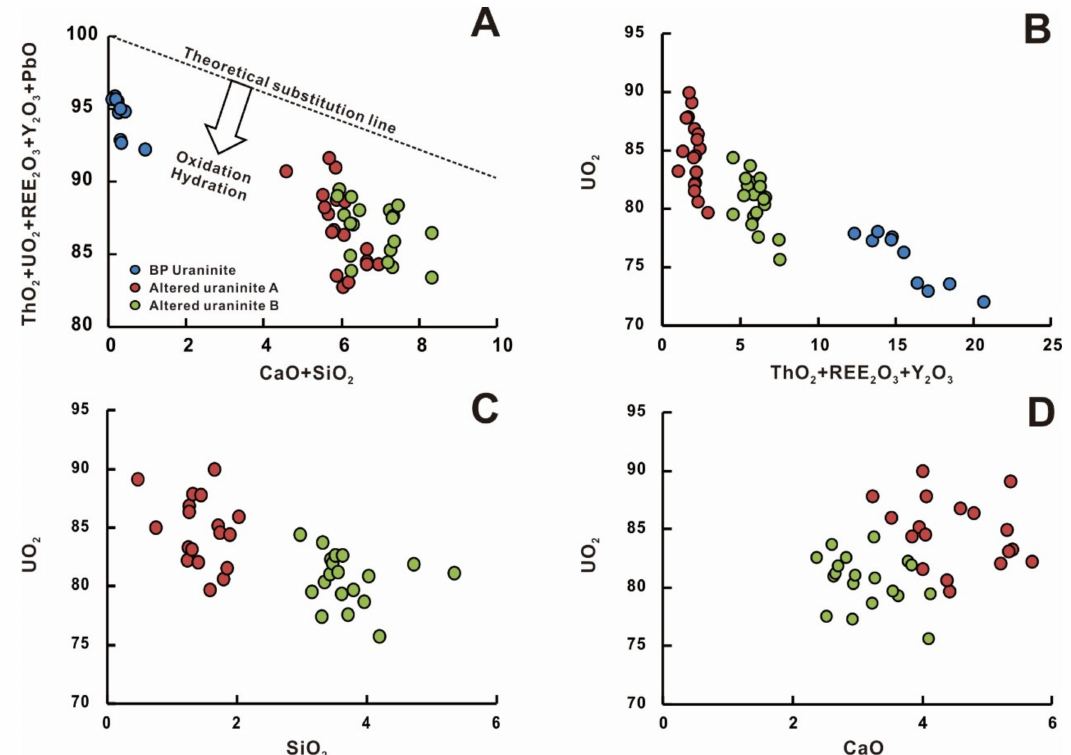
Figure 7. Binary diagrams of di ff erent major and minor elements in uraninite (in weight percent). ( A ) ThO 2 + UO 2 + REE 2 O 3 + Y 2 O 3 + PbO vs. CaO + SiO 2 shows that uraninite was subjected to significant hydrothermal alteration. ( B ) UO 2 vs. ThO 2 + REE 2 O 3 + Y 2 O 3 ; BP uraninite and